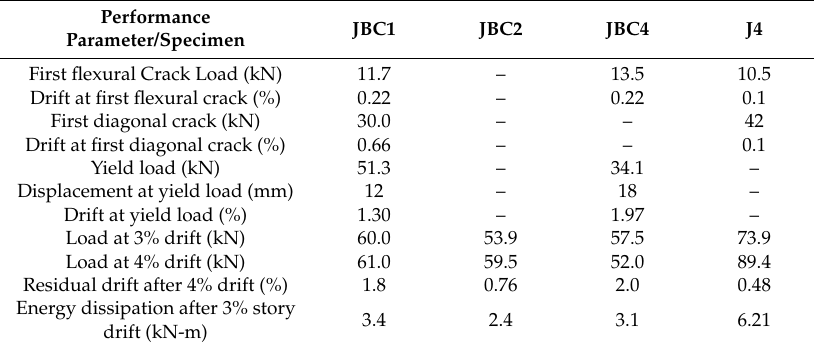
Table 2. Comparative test results of specimens.